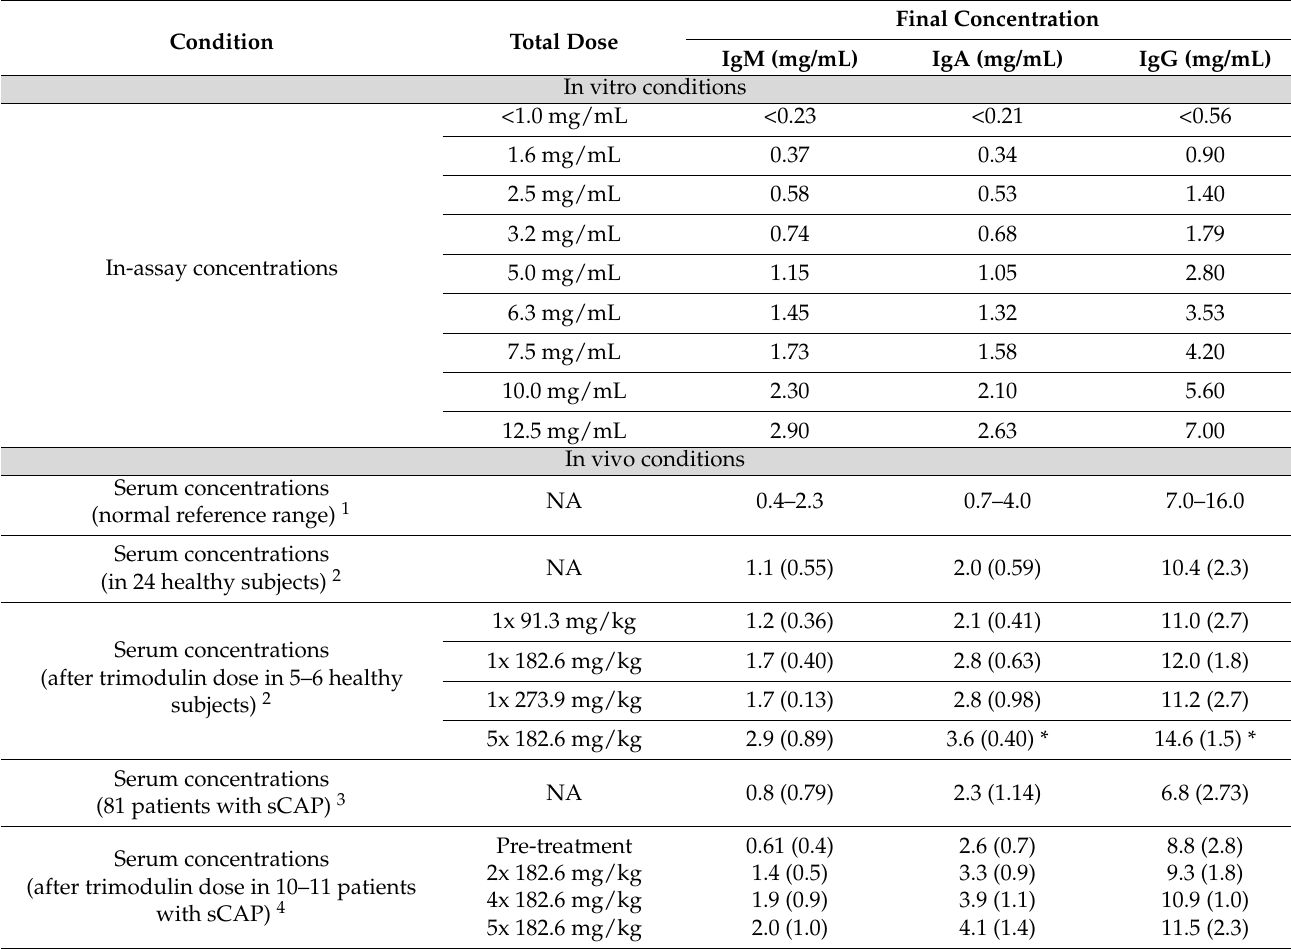
Table 1. Overview of IgM, IgA and IgG concentrations used in trimodulin assays and detected in humans before and after trimodulin